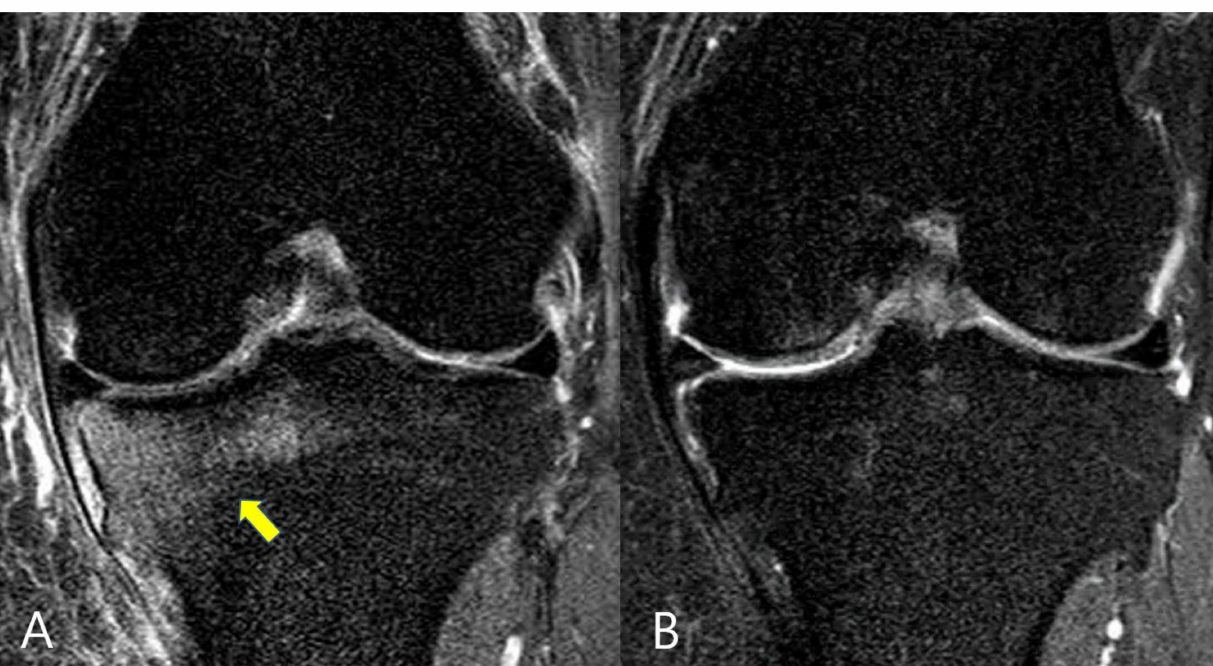
Figure 2. Magnetic resonance imaging (MRI) scans of a patient with a medial meniscus posterior root tear. ( A ) Pre-operative MRI view with a bone marrow edema lesion on the medial tibial plateau (yellow arrow). ( B ) One-year follow-up MRI view showing no bone marrow edema lesion on the medial tibial plateau.